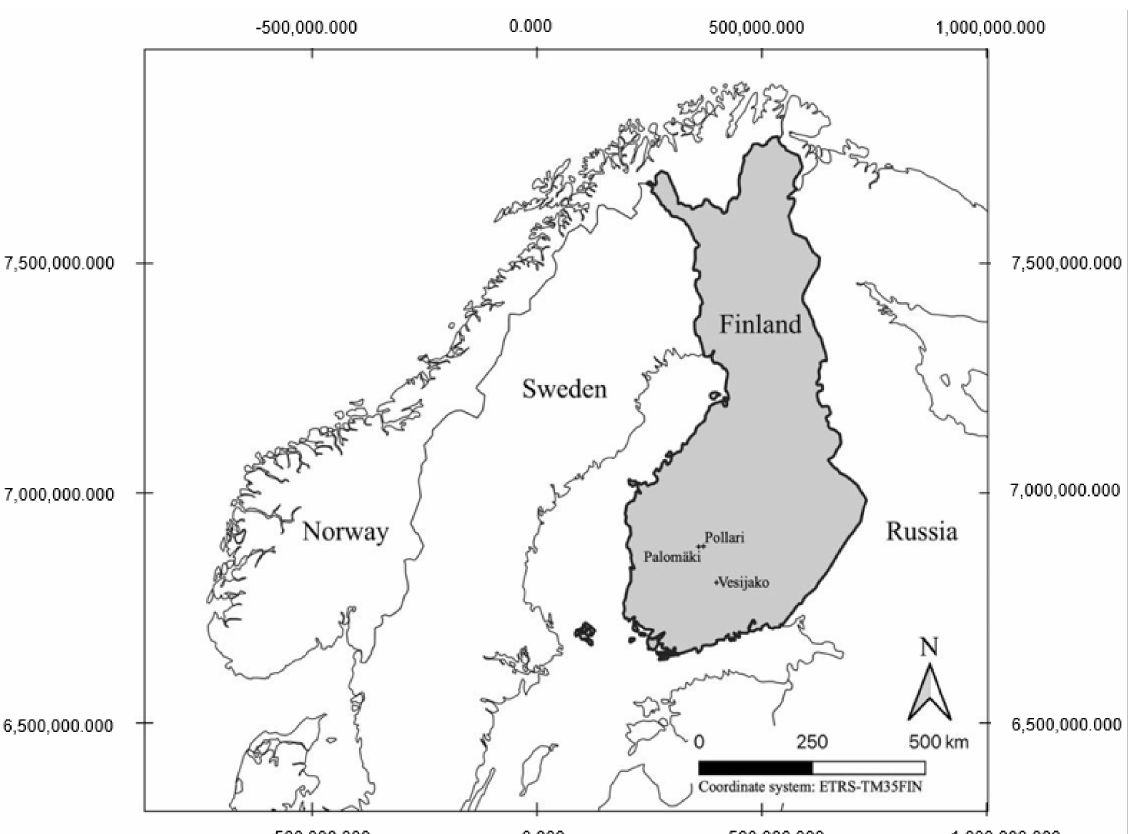
Figure 1. Location of three study sites namely Palomäki (62 ◦ 3.6 (cid:48) N 24 ◦ 19.9 (cid:48) E), Pollari (62 ◦ 4.4 (cid:48) N 24 ◦ 30.1 (cid:48) E) and Vesijako (61 ◦ 21.8 (cid:48) N 25 ◦ 6.3 (cid:48)